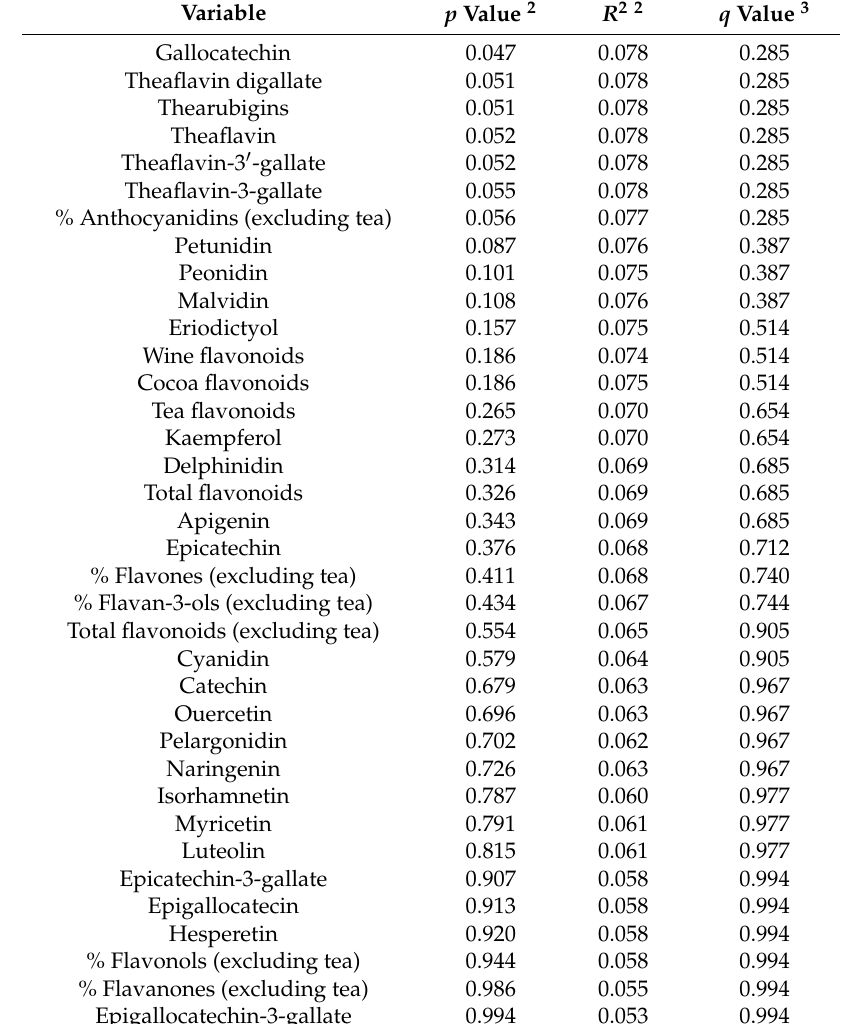
Table 1. Associations between flavonoid intakes 1 and gut microbiome based on unweighted UniFrac